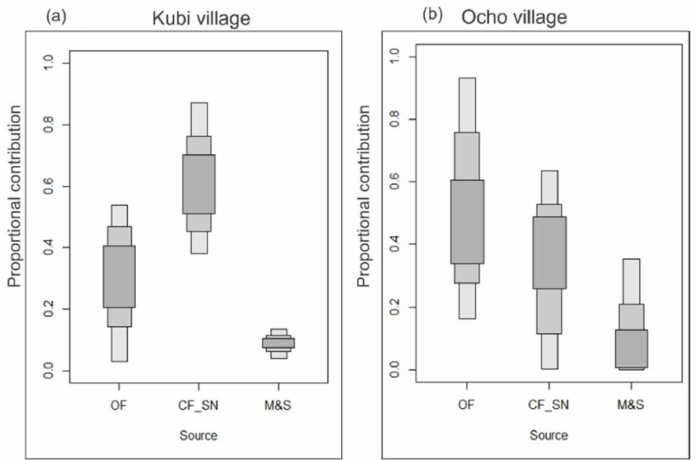
Figure 8. Spatial proportional contributions of NO 3 − sources estimated using SIAR in ( a ); Kubi and ( b ); Ocho village. Boxplots illustrate the 50th, 75th, and 95th percentiles from dark to